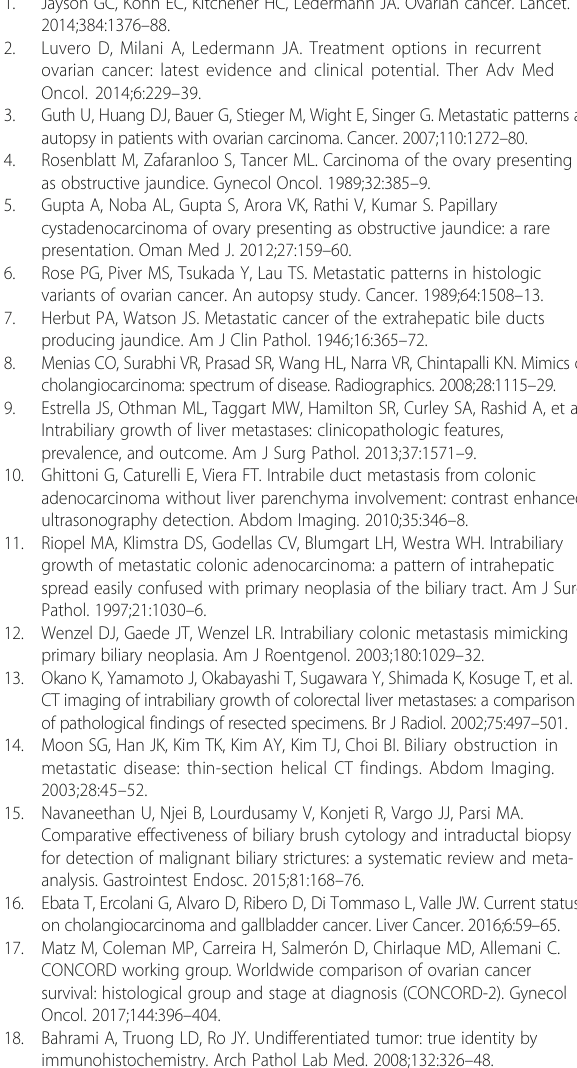
FIGO: International federation of gynecology and obstetrics; IDUS: Intraductal ultrasonography; PTPE: Percutaneous transhepatic portal embolization; SUV: Standardized uptake value; WT-1: Wilms